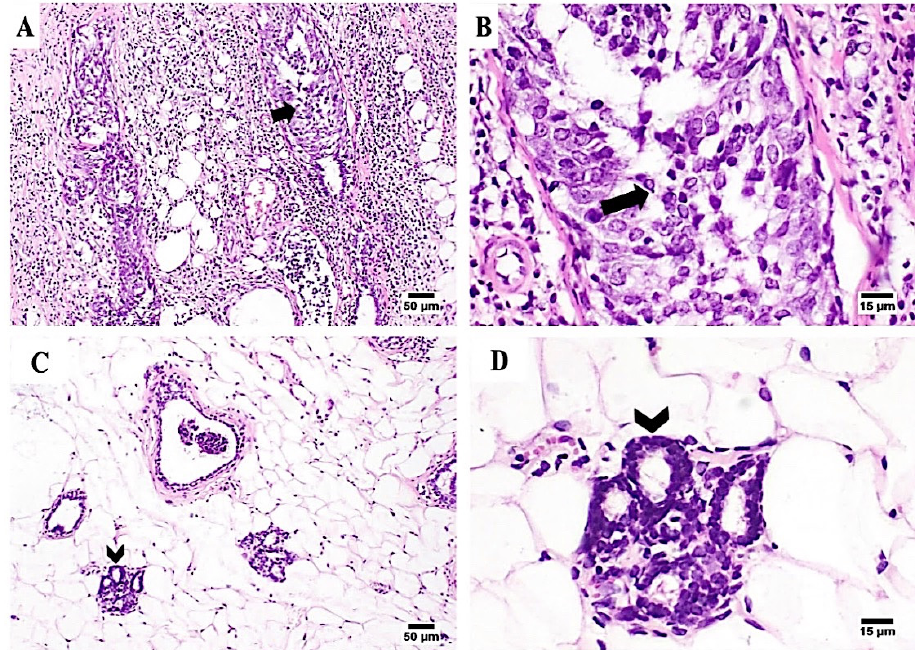
Figure 7. Photomicrographs showing the histopathological traits observed on tumor-induced mam- mary gland tissues. ( A , B ) Non-treated mammary gland showing malignant cells proliferation (arrows); H&E 100 × , and 400 × , respectively. ( C , D ) Mammary gland treated with chitosan hydrogel showing proliferating neoplastic cells forming ducts, without inward growths, cells clusters, or sheets, with mild inflammatory cells infiltration (chevrons); H&E 100×, and 400×, respectively.